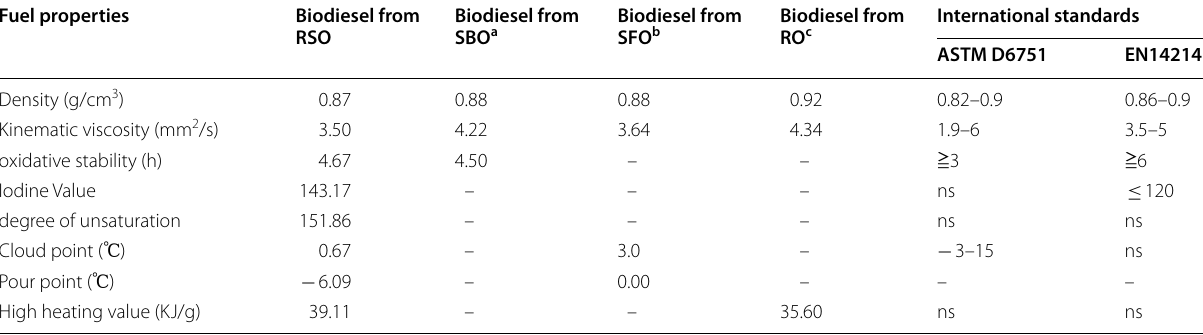
Table 6 Estimation of the biodiesel fuel properties of rubber seed oil in comparison with other biodiesel materials and the international standards for